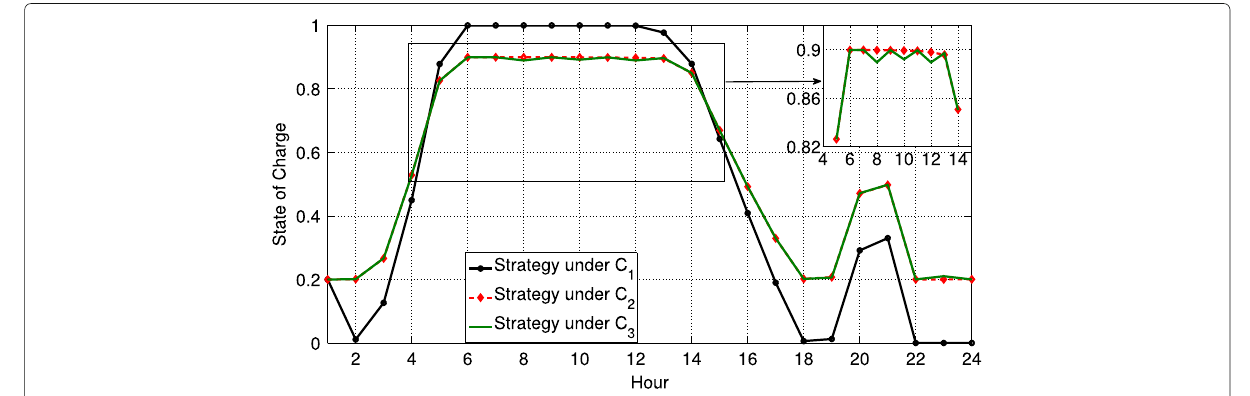
Fig. 8 Average SOC of the ideal strategy under the constraint sets C 1 , C 2 , and C 3